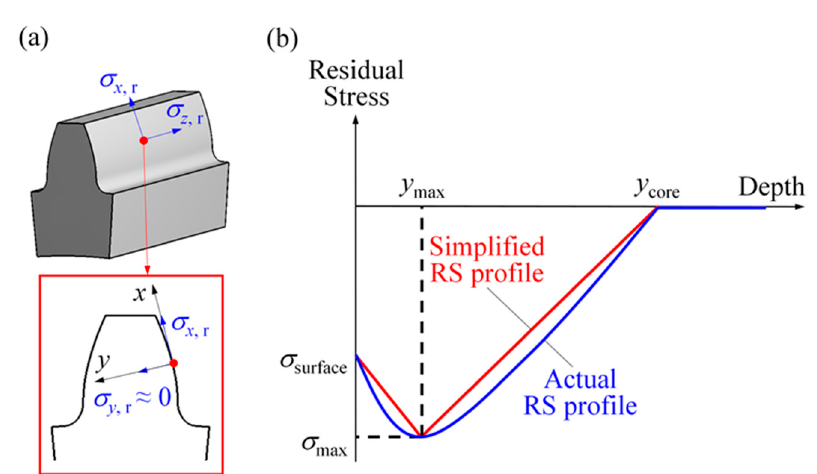
Figure 2. ( a ) RS components demonstrated on a gear tooth and ( b ) a simplified RS distribution profile along the depth.